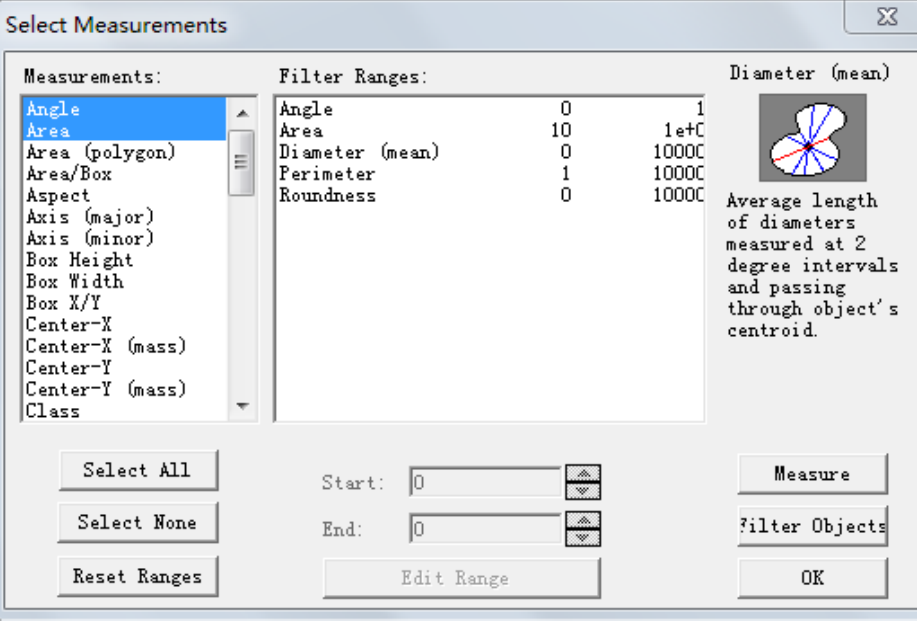
Figure 5. Schematic of selecting measurements.